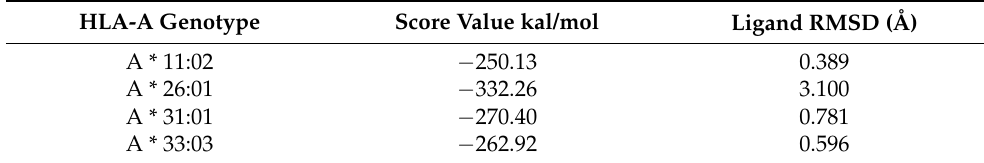
Table 2. CoDockPP butt mold